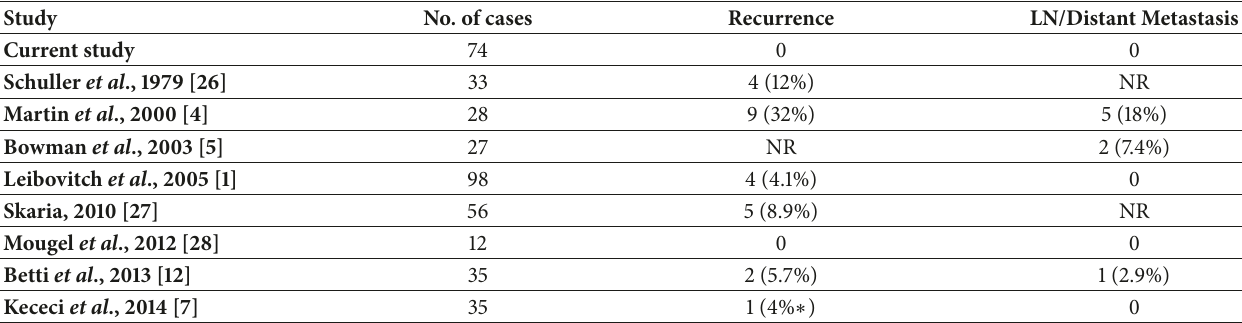
Table 1: A comparison of studies of the recurrence and metastatic rates of BSC following excision. NR = not recorded. ∗ = only 25/35 patients available for follow-up, hence the higher